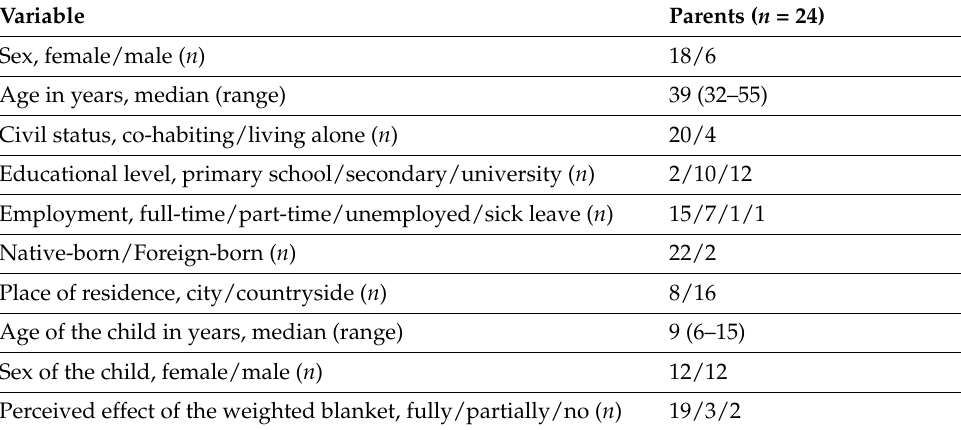
Table 1. Sociodemographic data of parents to children preferring weighted blankets ( n =